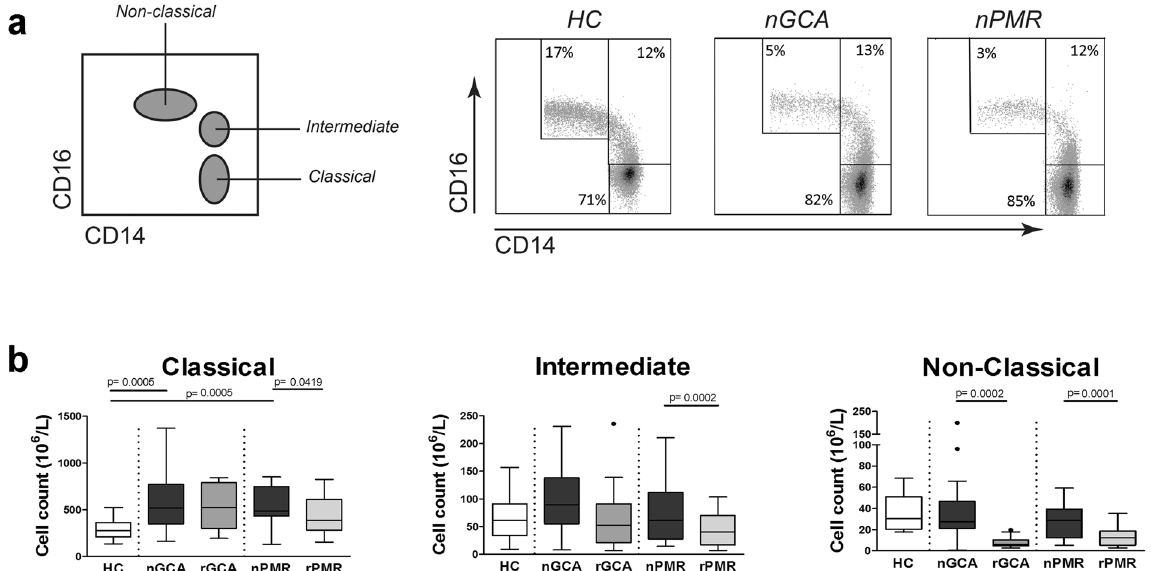
Figure 2. Altered distribution of monocyte subsets in GCA and PMR. ( a ) Flow cytometry gating strategy based on CD14 and CD16 expression to distinguish classical (CD14 bright CD16 neg ), intermediate (CD14 bright CD16 + ) and non-classical (CD14 dim CD16 + ) monocytes subsets (left panel). Flow cytometry dot plots showing representative samples (equal numbers of events) from a healthy control (HC), a newly diagnosed GCA patient (nGCA) and a newly diagnosed PMR patient (nPMR) (right panel). ( b ) Absolute numbers of classical, intermediate, and non-classical monocytes in HC (HC, n = 20), newly-diagnosed patients with GCA (nGCA; n = 21) and PMR (nPMR; n = 19) and in the follow-up samples of GCA (rGCA; n = 14) and PMR (rPMR; n = 15) patients in remission after 3 months of glucocorticoid treatment. Data are expressed as Tukey box and whisker plots. The bottom and top of the box represent the first and third quartiles, and the band inside the box represents the second quartile (the median). The whiskers represent the 1.5 IQR of the lower and the upper quartiles. Outliers are plotted as dots. The Kruskal-Wallis test was performed to compare data among study groups. The Mann-Whitney U test was used to compare each patient group with HC. Paired samples were compared with the Wilcoxon signed rank test. P-values of less than 0.05 (2-tailed) were considered statistically